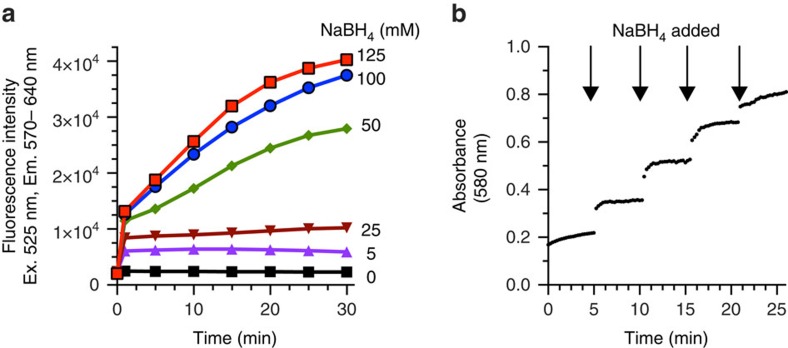
Influence of NaBH4 on deallylation of RAE.(a) Reaction lifetime dictated by NaBH4 concentration. Conditions: 29 μM RAE, 10 p.p.b. Pd(II), 200 μM TFP, 800 mM NH4OAc, 0–125 mM NaBH4, EtOH, 25 °C. (b) Stalled deallylation reaction can be restarted by NaBH4 addition. Conditions: 29 μM RAE, 0.3 p.p.m. Pd(II), 200 μM TFP, 800 mM NH4OAc, 0. 0.6, 1.2, 1.8, 2.4 mM NaBH4, added as 2.5 M aliquots at indicated time points.